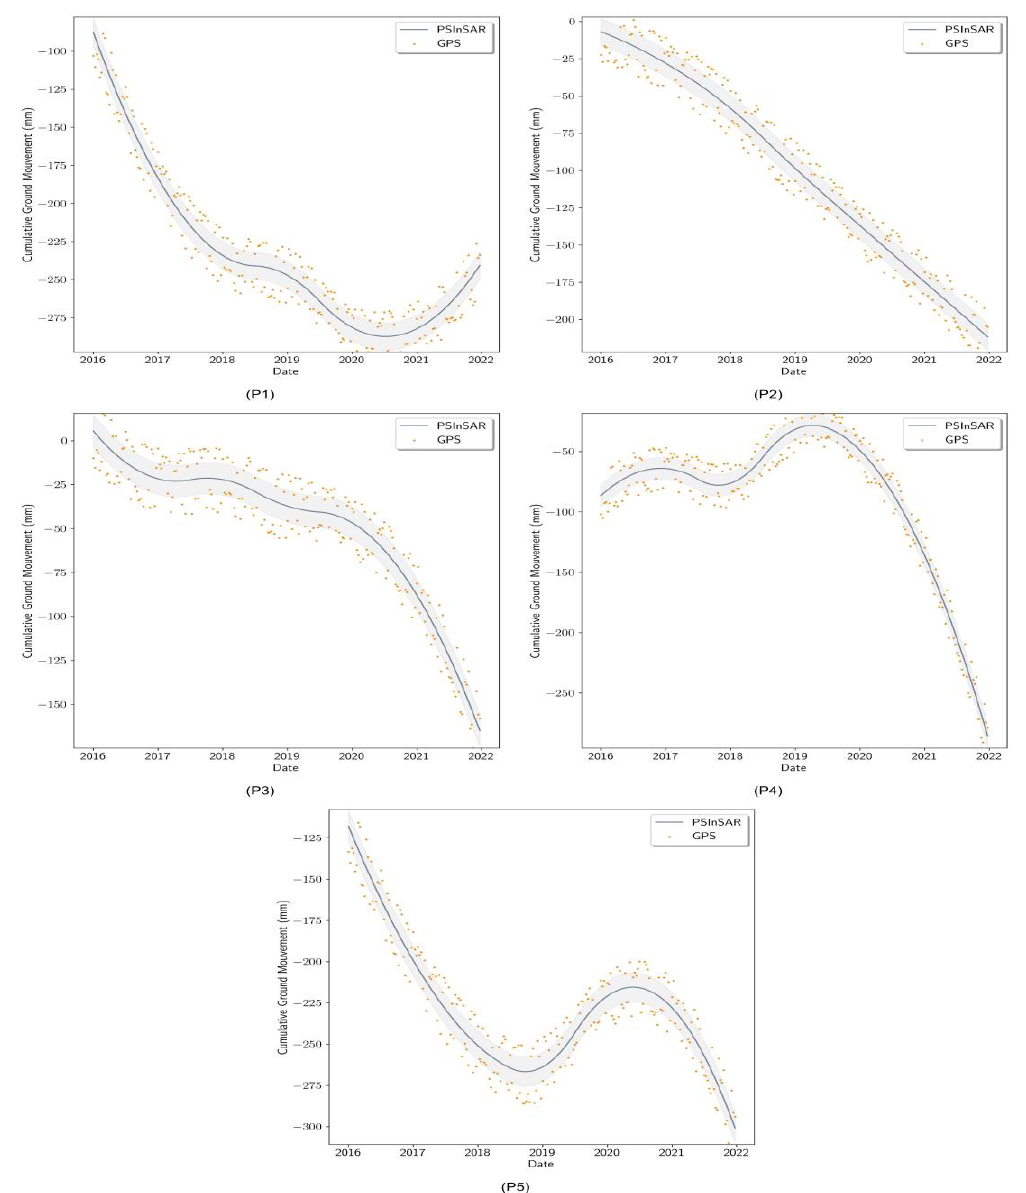
Figure 6. Graphs of the cumulative deformation of the selected points (P1, P2, P3, P4, and P5) from PSI and GPS results used to detect subsidence; the x -axis is time, 2016–2022, and the y -axis represents the movement of the ground.